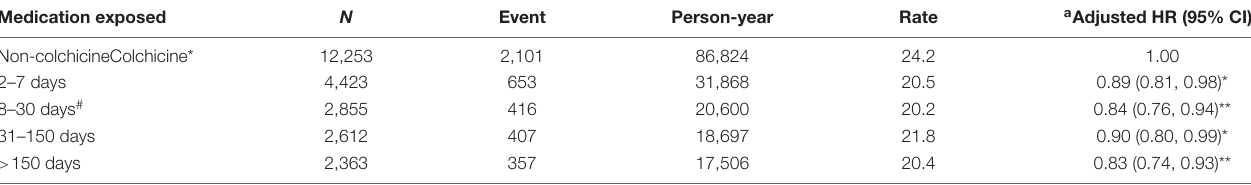
TABLE 4 | Incidence and adjusted HR of HD stratified by duration of colchicine therapy in patients with interstitial lung disease with virus infection cohort in the propensity-score-matched cohort. Medication exposed N